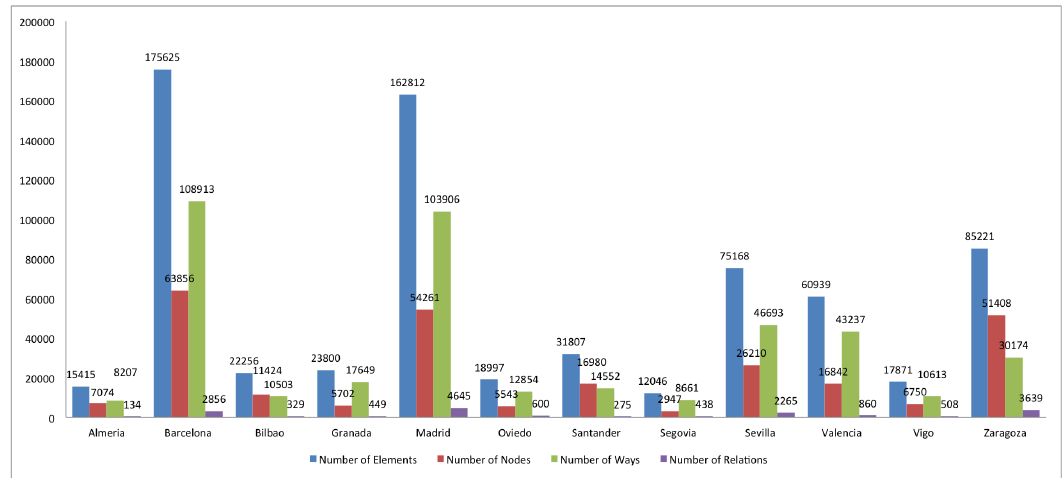
Figure 1. Summary of items, nodes, ways and relations in the Spanish cities under